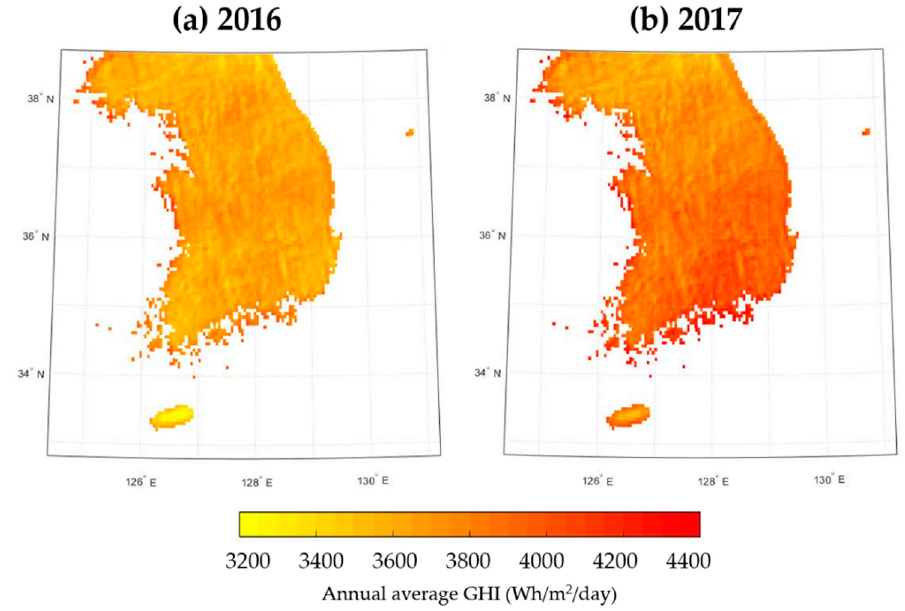
Figure 13. Generated annual solar irradiance map using ANN models.